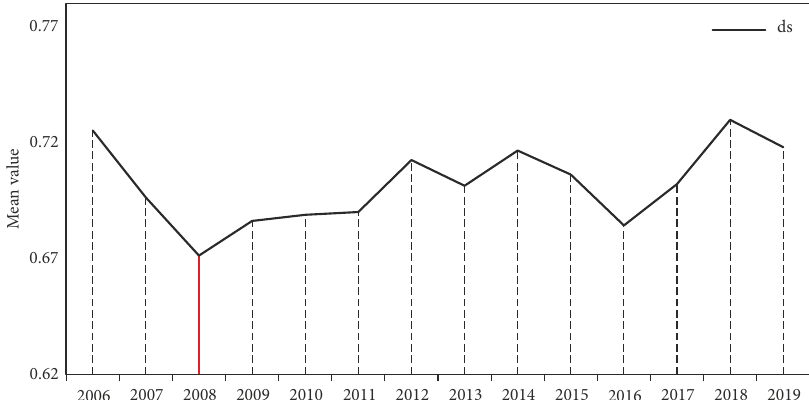
Figure 2. Annual trend of the mean value of corporate strategy